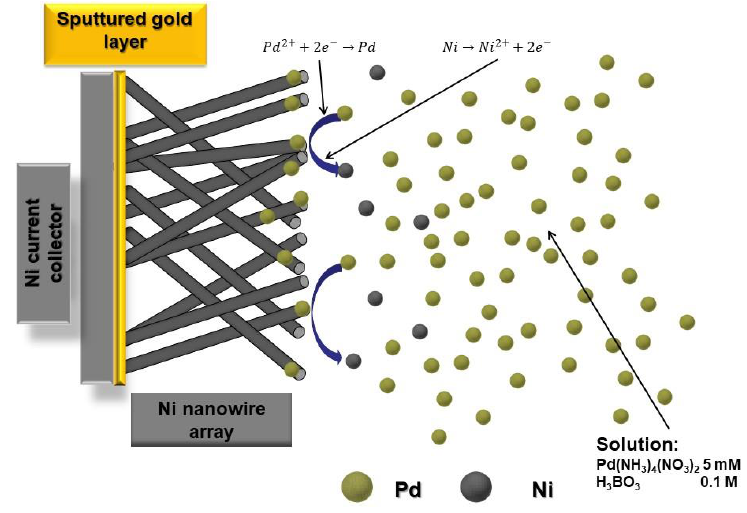
Figure 3. Scheme of galvanic displacement deposition of Pd on Ni-NWs.